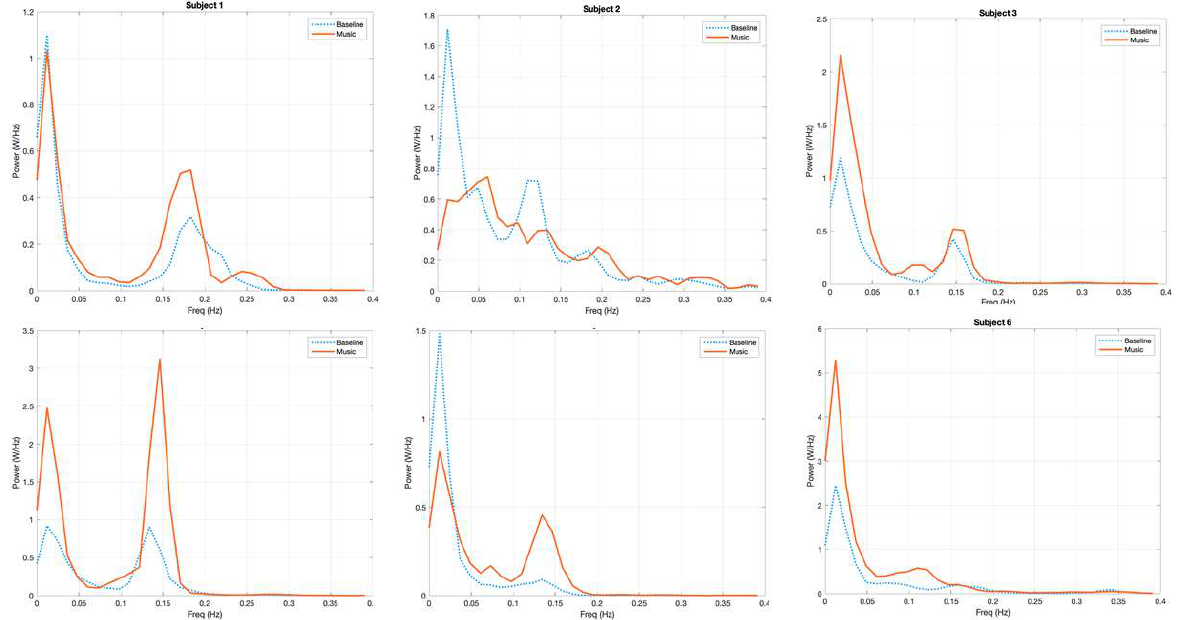
Figure 4. Power spectrum analysis of O2Hb fNIRS signal of each subject for the left hemisphere during the first baseline (blue, dashed curve) and the first music block (red, solid curve). The y -axis expresses the values of power (W/Hz); the x -axis shows the frequencies (Hz). Note that the values of power are variable for every subject due to different light conduction properties of the skin (e.g., depending on pigmentation and dryness) and optode adhesion.